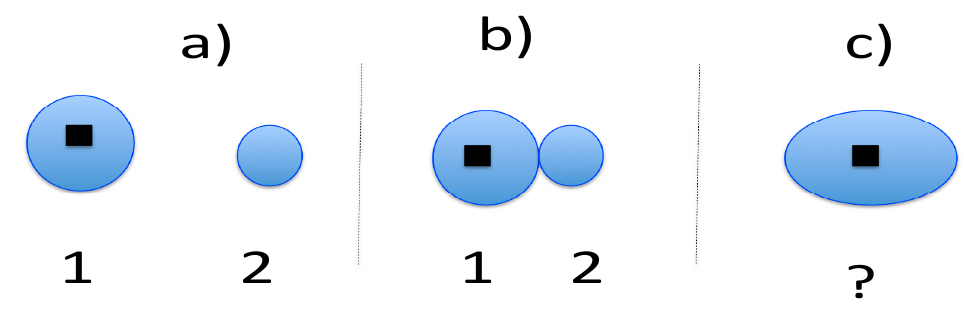
Figure 4. Two water drops on a smooth surface approach each other and coalesce. ( a ) The grain of sand is in the first drop; ( b ) the grain is still in the first drop; ( c ) in which of the two drops is the grain